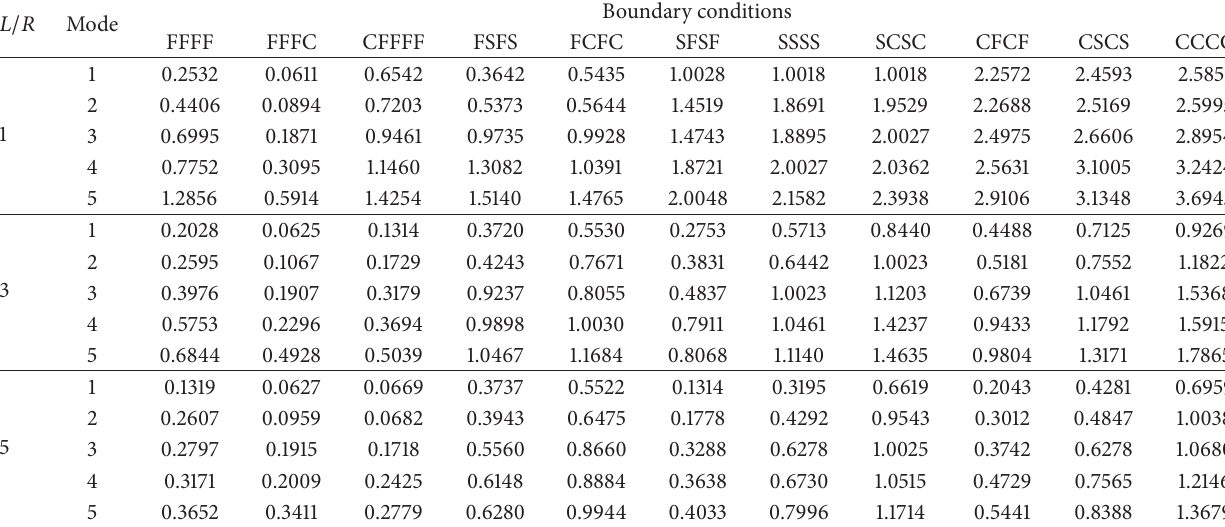
Table 7: The first five frequency parameters Ω = 𝜔𝑅√𝜌/𝐺 of an open isotropic cylindrical shell with various boundary conditions